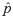
Comparison of the performance of the precursor-only and the on-off strategies after a nutrient upshift.A: Trajectory in the phase plane for the on-off strategy (yellow curve). The solid, black curve represents the p^-nullcline and the dashed, black curve the function g. The solution is obtained by numerical simulation of the system of Eqs 11 and 12, supplemented with the equation α=h(p^,r^) defined in Eq 19 and plotted in Fig 8A. The initial state corresponds to the optimal steady state attained for an environment given by 0.2EM. B: Trajectory in the phase plane for the precursor-only strategy (same as in Fig 6B, added for comparison). C: Evolution of the control variable α for each strategy as a function of time. Both strategies stabilize the system at the optimal steady state, but only the on-off strategy (yellow curve) exhibits bang-bang behavior. D: Evolution of the ratio Vol/Volopt for the on-off and precursor-only strategies as a function of time, where Vol is the volume of the self-replicator and Volopt the volume of the same replicator following the optimal strategy shown in Fig 4. The final values of Vol/Volopt attained by the two strategies are 0.9831 and 0.9413, respectively. The on-off strategy is thus hardly distinguishable from the optimal control strategy in the plot. In all of the above simulations, the parameter values EM = 1 and K = 0.003 were used.